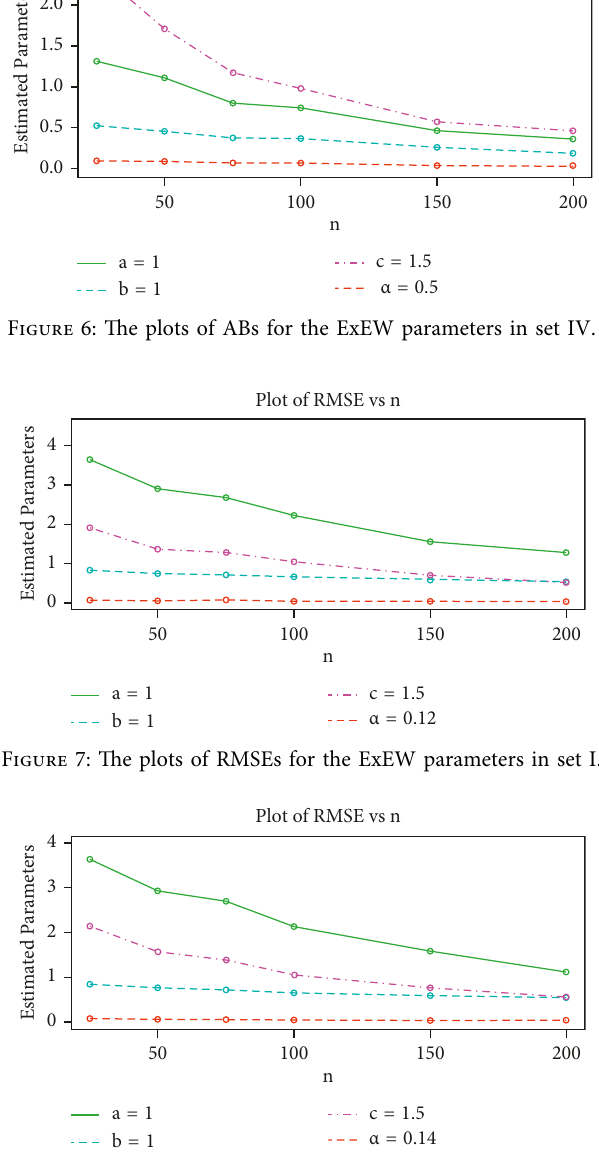
Figure 4: The plots of ABs for the ExEW parameters in set II.